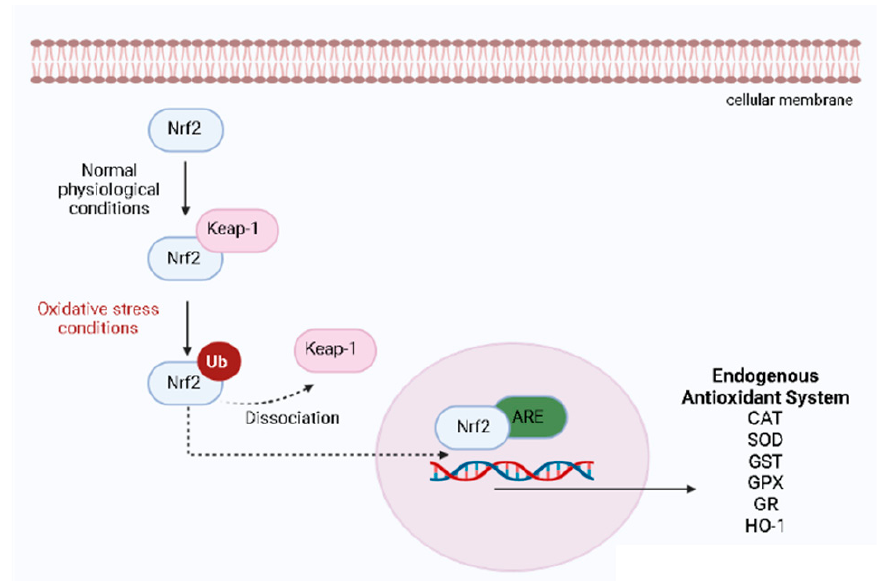
Figure 3. Activation pathway of Nrf2 and the production of endogenous antioxidant molecules. ARE, antioxidant response element; GST, glutathione S-transferase; HO-1, heme oxygenase-1; NQO1, NAD(P)H: quinone acceptor oxidoreductase 1; Nrf2, nuclear erythroid 2-related factor. The illustration was drawn using BioRender software.